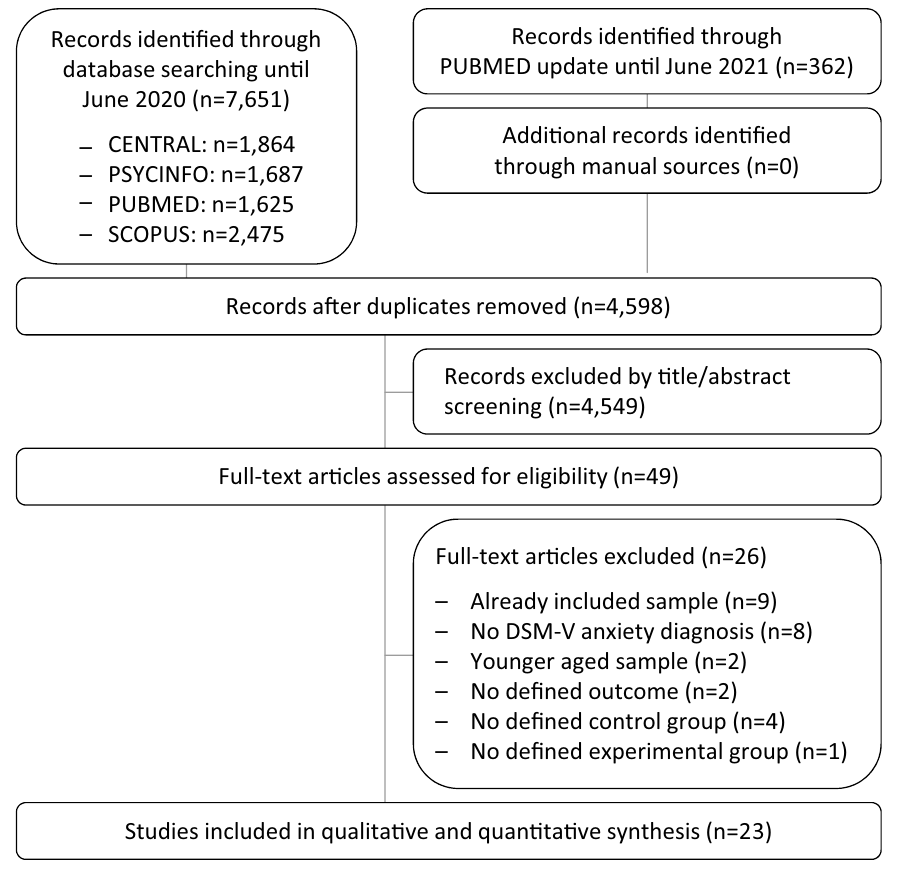
Figure 1. PRISMA flow